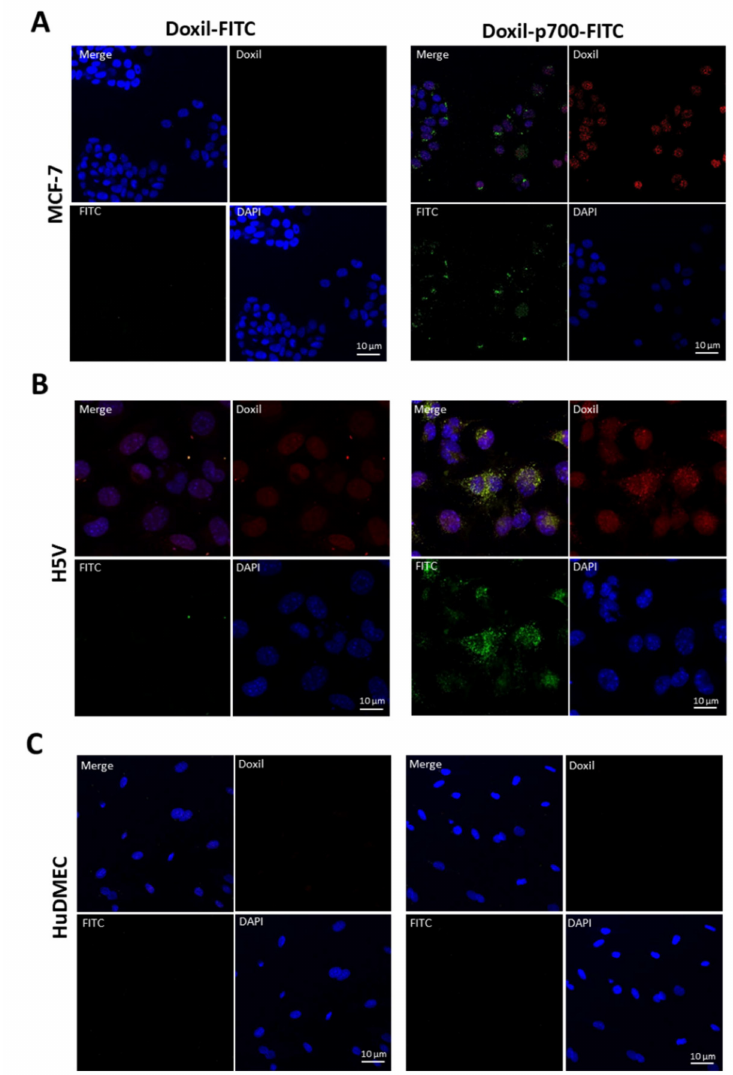
Figure 4. Uptake of Doxil and Doxil-p700 by H5V, MCF-7 and HuDMEC after 9 h. HV5 ( A ), MCF- 7 ( B ) or HuDMEC ( C ) were treated with Doxil-FITC or Doxil-p700-FITC, as indicated, at 275 nM for 9 h at 37 ◦ C and then imaged by confocal microscopy. Red staining is doxorubicin, green staining is FITC on the peptide conjugate and blue DAPI nuclear